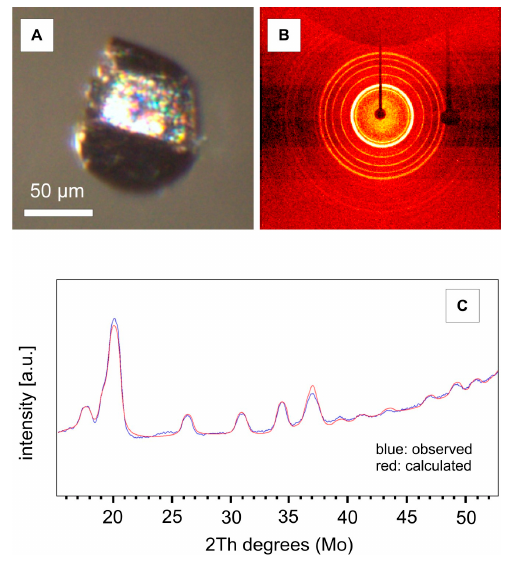
Figure 4. ( A ) Stereomicroscope image of the unpolished fibrous PGM grain showing metallic luster; ( B ) Debye rings for the fibrous PGM, observed on the two dimensional detector; ( C ) Rietveld refinement of the obtained one dimensional conventional diffractogram [19] and the resulting XRD pattern for the fibrous PGM (observed and calculated).